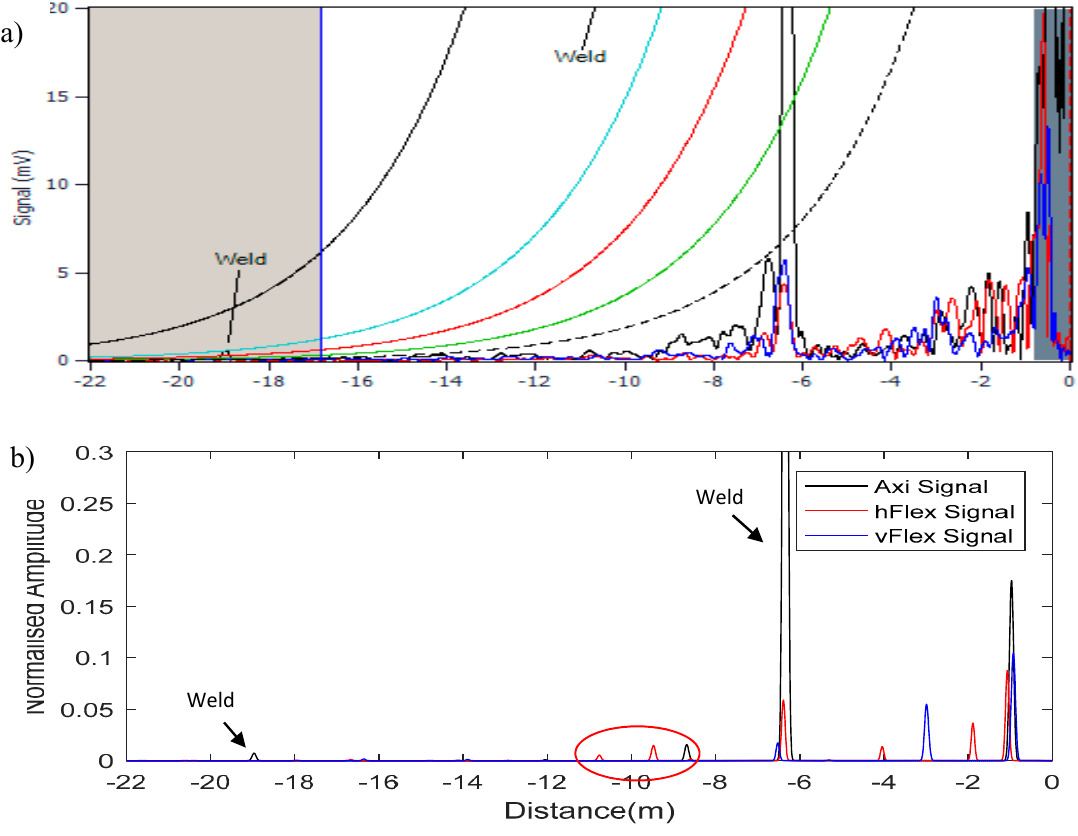
Figure 13. Field data #1; ( a ) Teletest data; ( b ) SSP